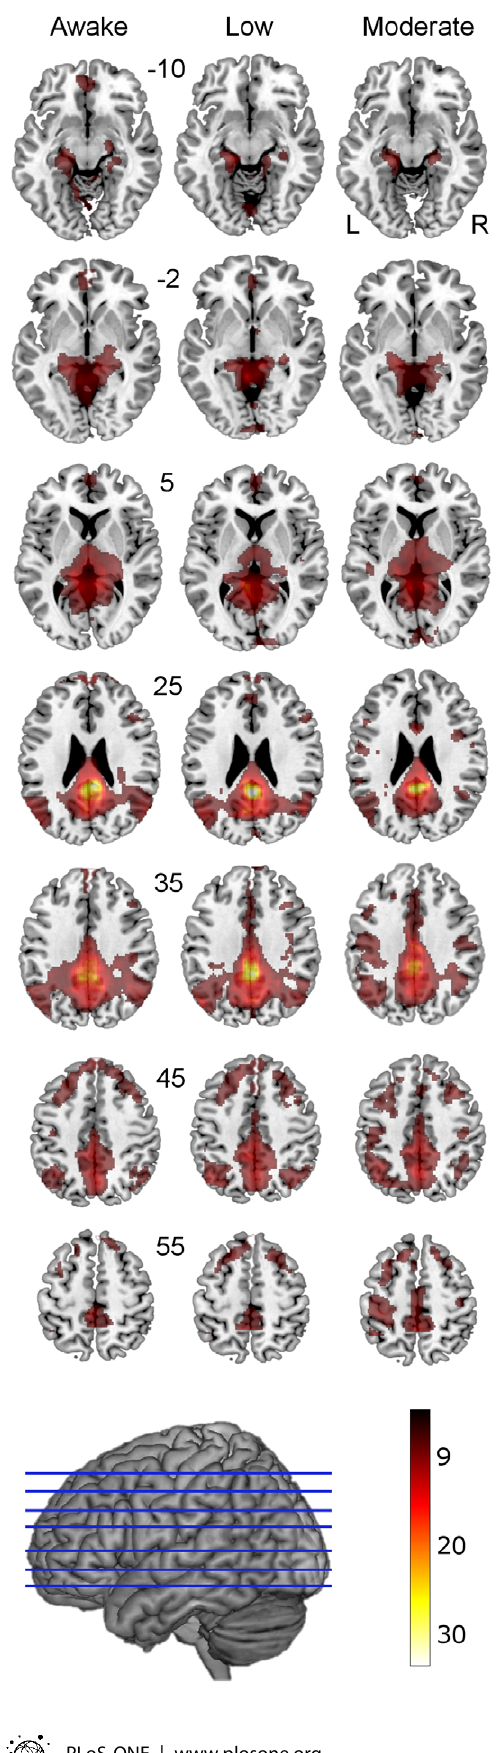
Figure 1. PCC connectivity at awake, low and moderate levels of sedation shown superimposed on a standard T1 weighted structural image. Talairach and Tournoux z coordinates are shown. The connectivity of the PCC appears to increase with sedation, especially in motor and somatosensory areas. We report clusters that survived a voxel threshold of p # 0.001 uncorrected and a random field cluster threshold of p # 0.05 corrected for the entire brain. The color bar indicates strength of connectivity (t